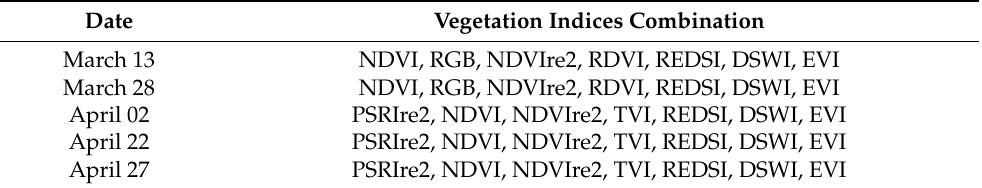
Table 3. Vegetation indice combinations after similarity removal at five dates. Each row represents the vegetation indice combinations after the similarity removal on the corresponding